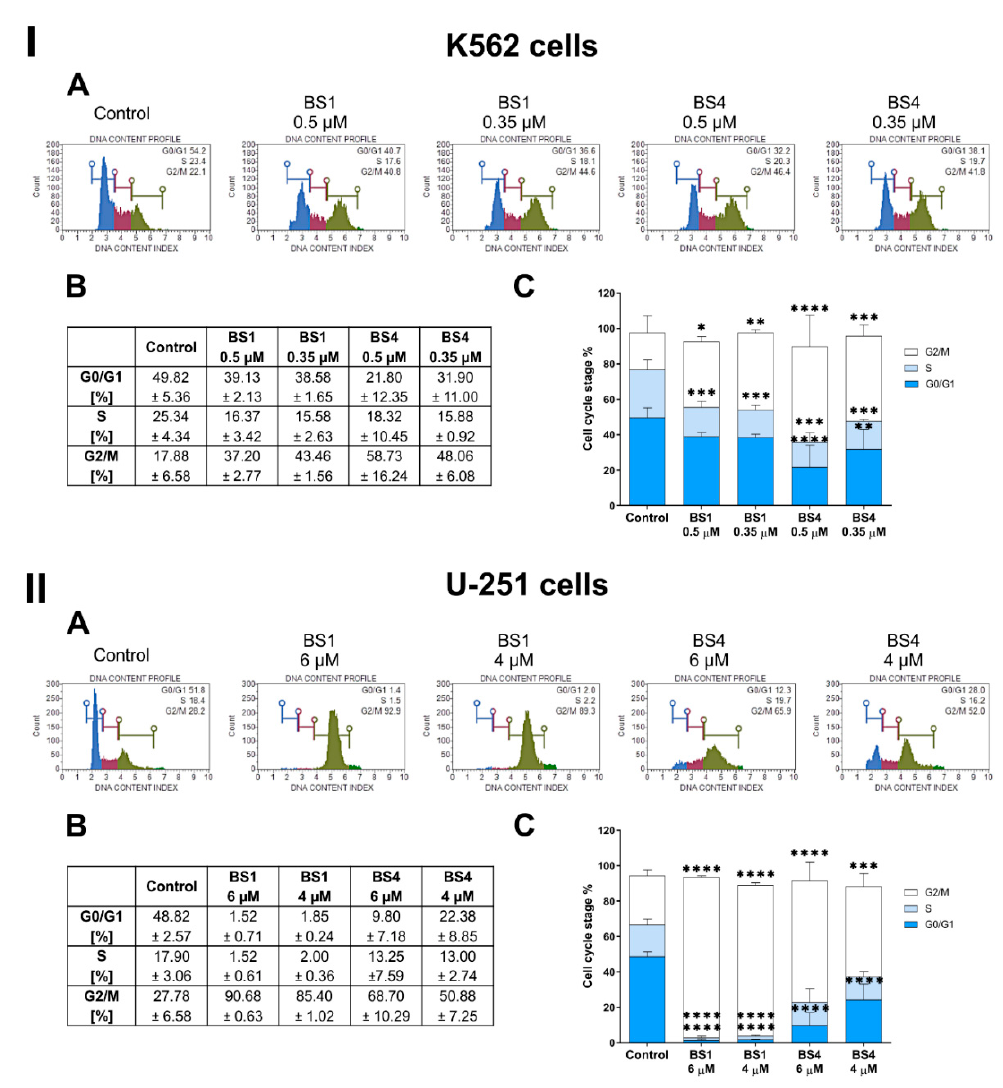
Figure 3. Effect of the treatment with the selected compounds ( BS1 , BS4 ) at various concentrations on regulating the cell cycle in the K562 ( I ) and U-251 ( II ) cells. The representative histograms with the distribution of the cells in the respective phases of their cycles for one of several independent experiments ( A ). The table includes the mean ± SD percentage of the cells in the respective phases of the cell cycle from all of conducted experiments ( B ). Data chart with the statistical analysis using a one-way ANOVA with Bonferroni’s post-hoc test: * p < 0.05, ** p < 0.01, *** p < 0.001, **** p < 0.0001 compared to the untreated cells (control) ( C ).